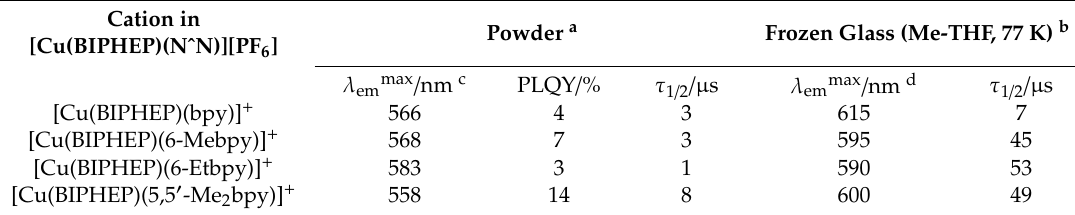
Table 4. Emission maxima, photoluminescence quantum yields (PLQY) and lifetimes ( τ 1 / 2 ) for [Cu(BIPHEP)(NˆN)][PF 6 ] complexes.